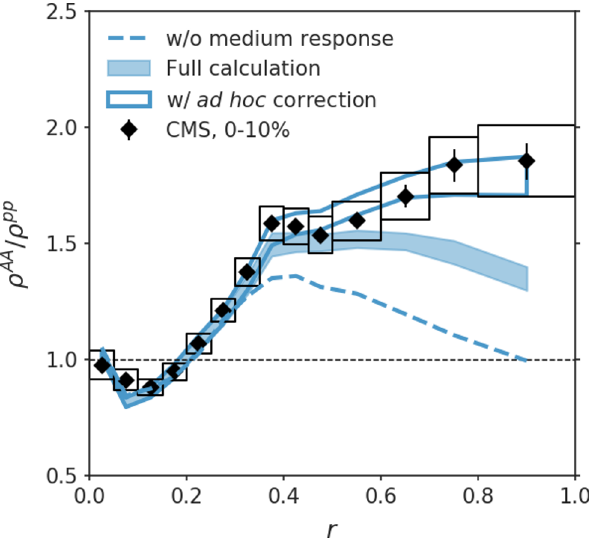
Figure 15 . Prediction of the ratio between inclusive jet shape in Pb-Pb collisions and p-p collisions (blue band) compared to data from the CMS experiment [109]. The dashed line is the central prediction of jet shape without contributions from medium excitations. The blue open band is the result corrected by the ad hoc formula in equation (5.5), where a (cid:15) = 0 . 37 GeV per squared-radian 0 energy density is subtracted from the transverse-momentum profile calculation for Pb-Pb and